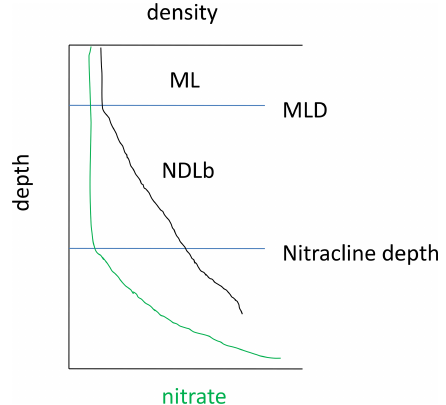
Figure 2. Diagram showing the mixed layer (ML) and the bottom of the nitrate (NO3)-depleted layer (NDLb), delineated by the ni- tracline depth and the mixed layer depth (MLD) as defined in this